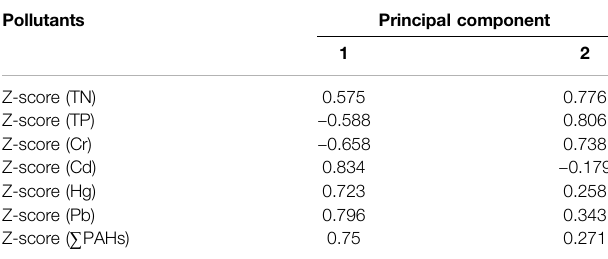
TABLE 3 | Principal component load matrix of the pollutants in the stormwater